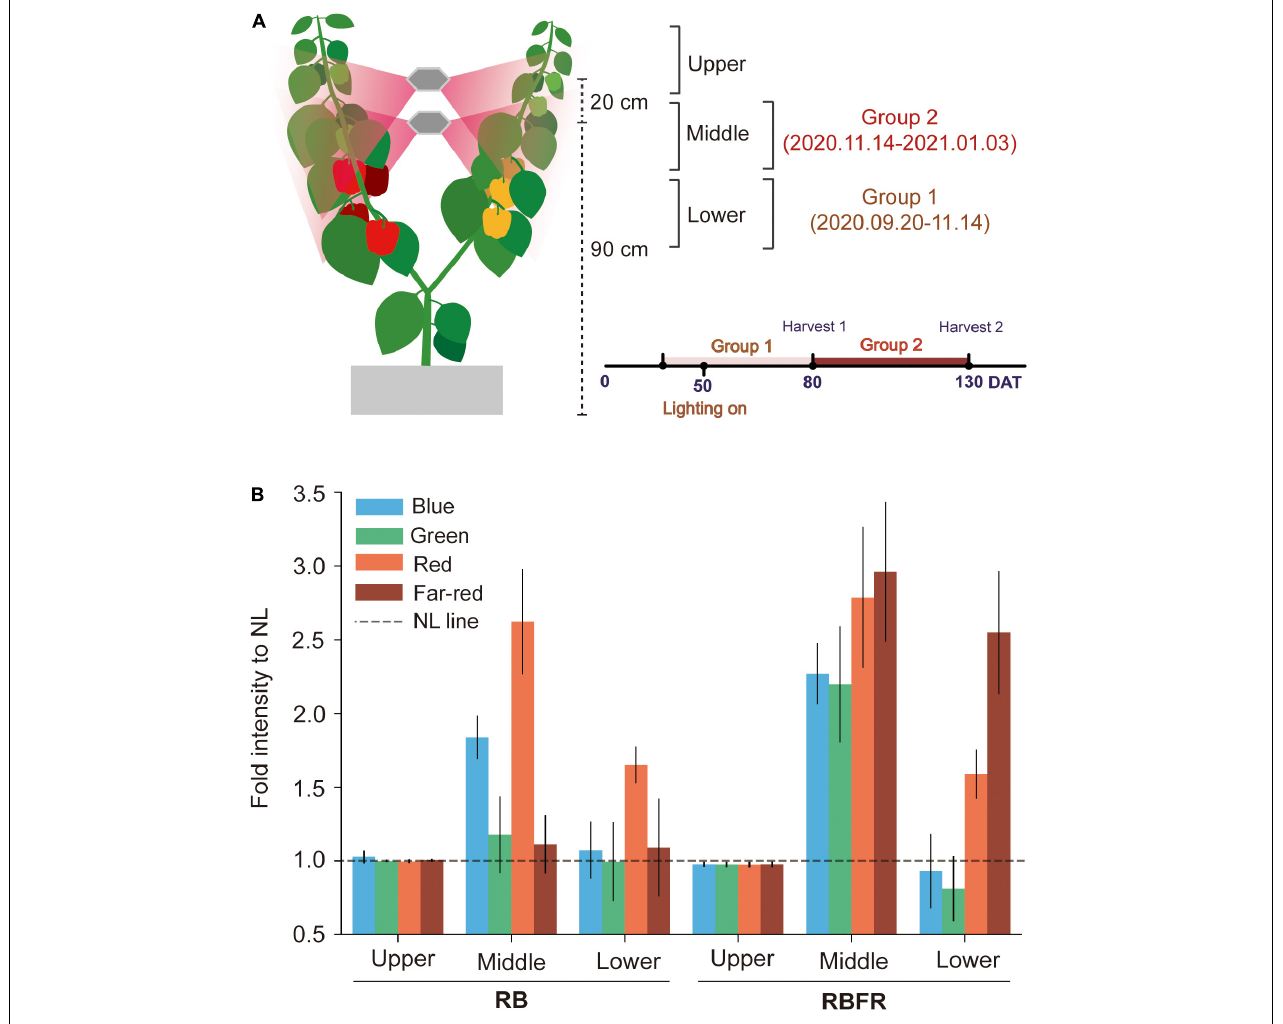
FIGURE 2 | Fruit sampling groups and spectral light distribution in sweet pepper canopy positions. Representation of the fruit harvesting groups and sampling positions (A) , and fold intensity of spectral distributions compared to NL from interlighting RB and RBFR measured at the upper, middle, and lower canopy positions (B) . NL, RB, and RBFR mean natural light, NL with red + blue LED interlighting, and RB with far-red light, respectively. DAT means days after transplanting, spectral ranges of blue, green, red, and far-red were 400–500, 500–600, 600–700, and 700–750 nm, respectively. Values are the mean ± standard deviation ( ± SD) of 20